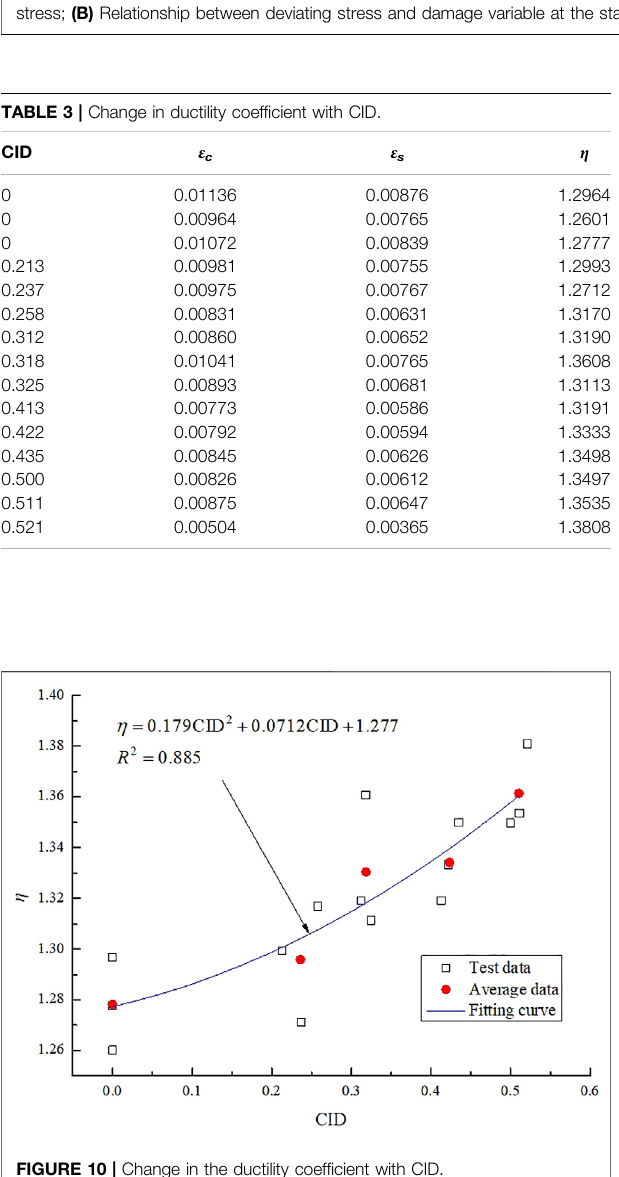
FIGURE 9 | Triaxial compression dilatancy characteristics of coal samples with different degrees of CID: (A) Relationship between volumetric strain and deviating stress; (B) Relationship between deviating stress and damage variable at the starting point of expansion.